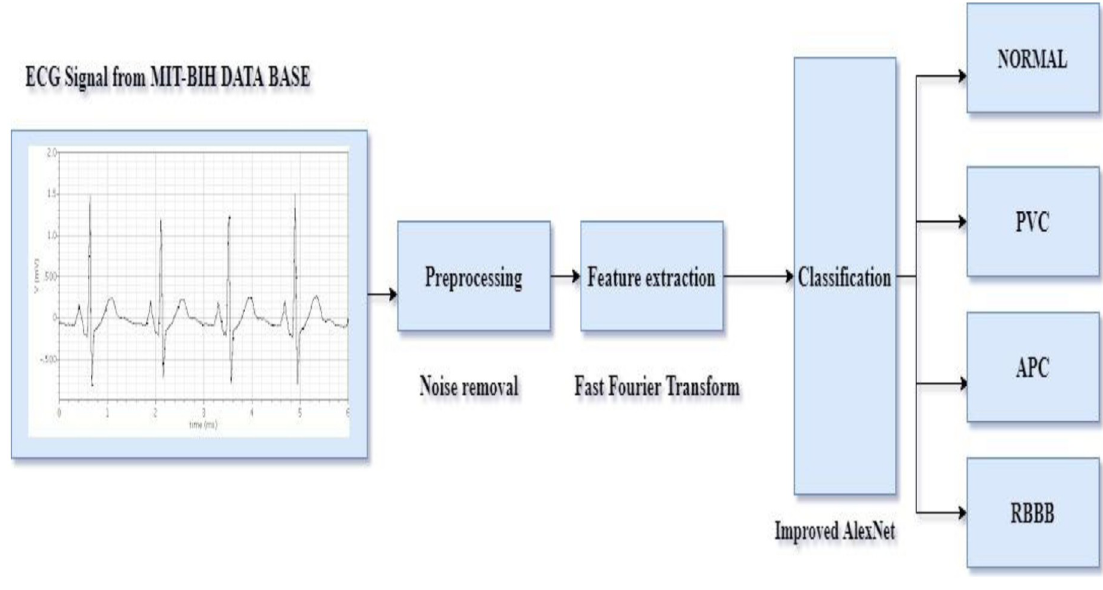
Fig 1. ECG signal processing